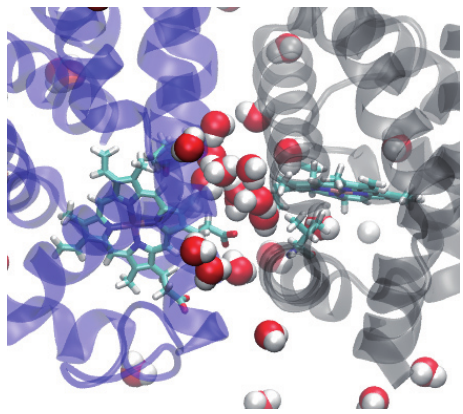
Figure 7. The interface of the F97V mutant showing the interfacial water molecules that are still present after 10 ns of